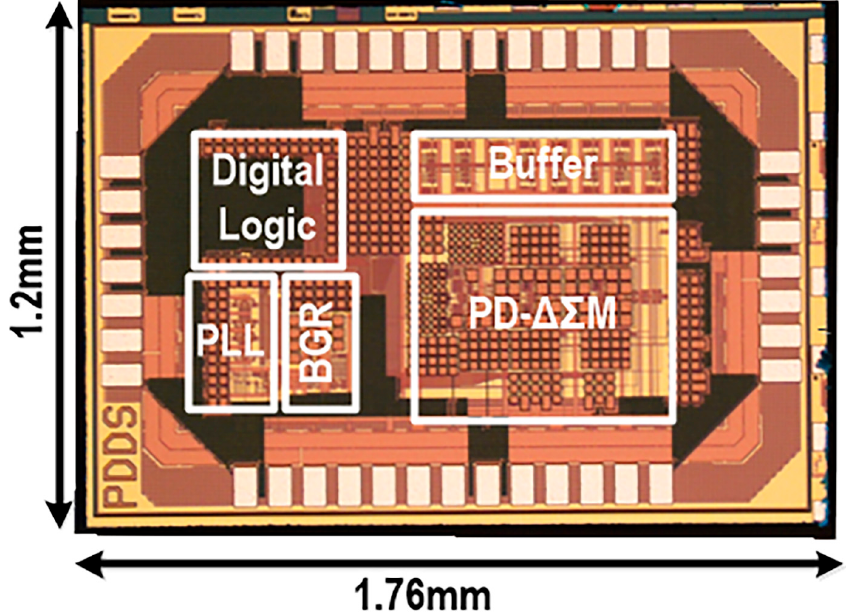
Figure 6. Chip microphotograph of the portable phase-domain MIT transceiver.